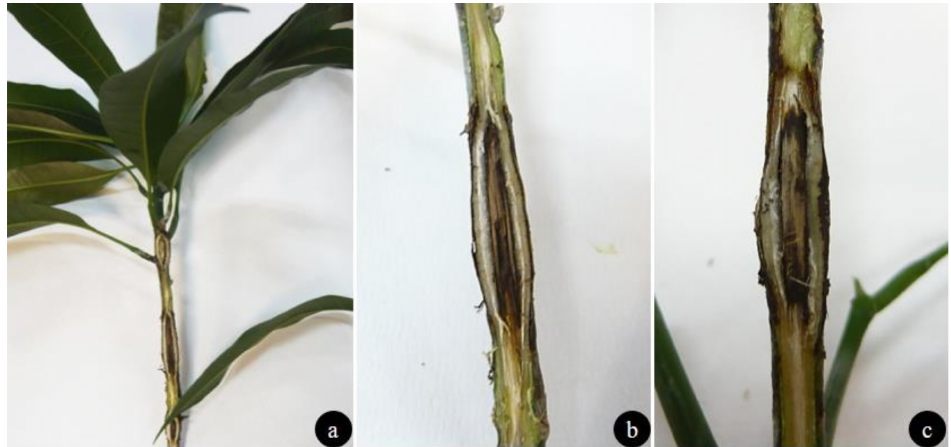
Figure 8. Woody cankers on litchi plants cv. Way Chee 30 days after inoculation with ( a , b ) Diaporthe rudis ; ( c ) D. baccae